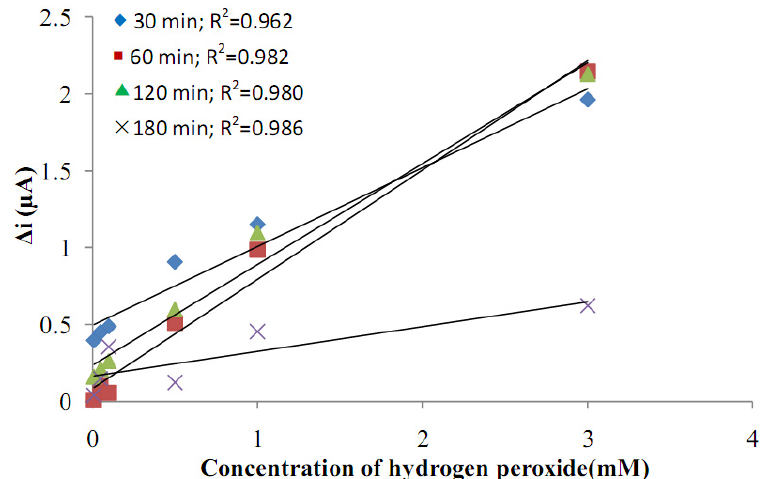
Figure 3. Effect of the film thickness on the response of the Pt/Pani-Pvs electrode to hydrogen